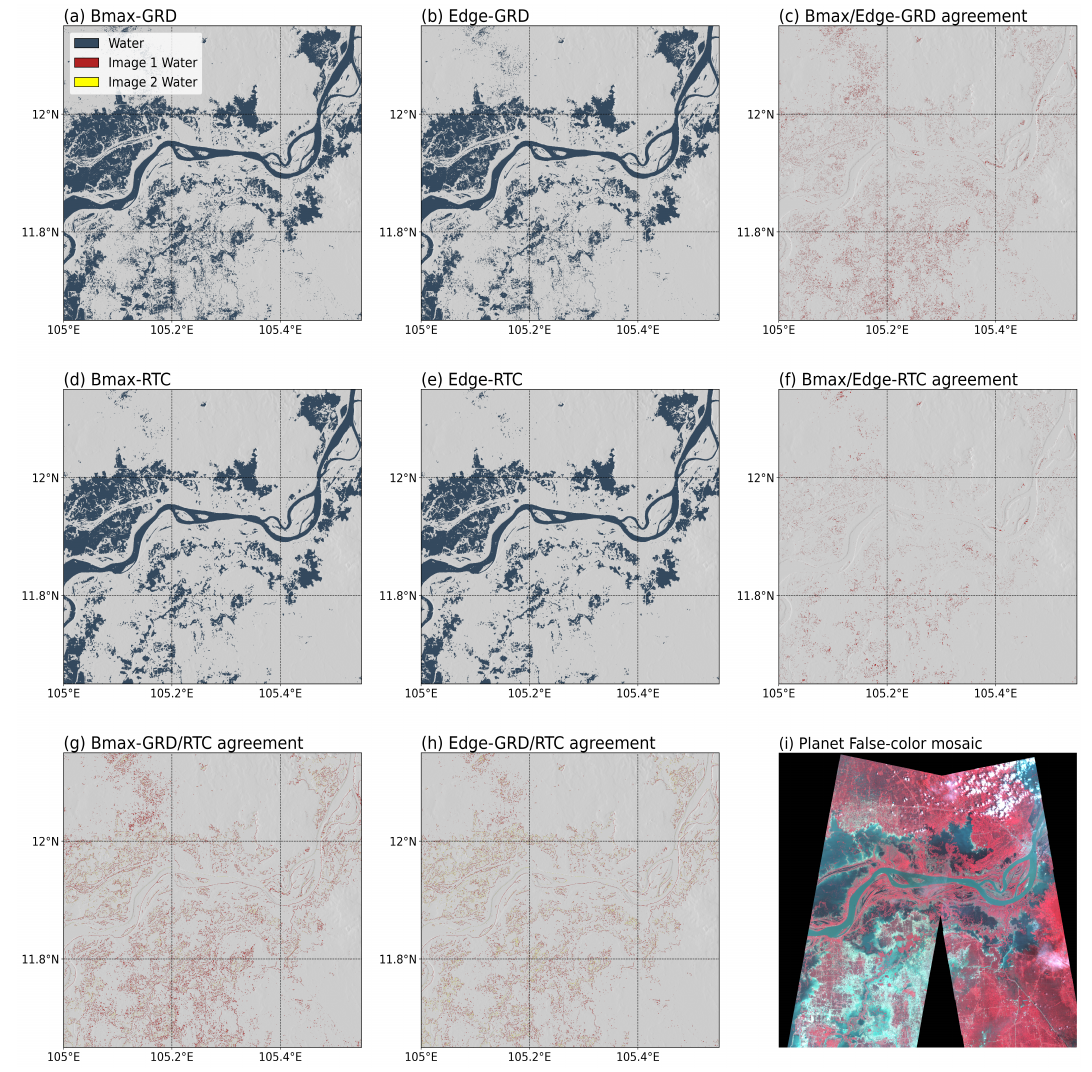
Figure 5. Surface water maps generated over the Tonlé Sap River and Lake in Cambodia for 2019-10-05 using the Bmax Ostu algorithm with the GRD dataset ( a ) and RTC datasets ( d ), as well as the Edge Otsu algorithm with GRD ( b ) and RTC ( e ) data. Difference maps between the methods using either the GRD (c) or RTC ( f ) datasets are provided. The difference maps between datasets using either the Bmax Ostu ( g ) and Edge Otsu ( h ) algorithms is also provided. Image differences are denoted in either red for areas only water from Image 1 is present and yellow for for areas only water from Image 2 is present. Image 1 for the difference maps is the first image used to find the difference starting from either top row or left column whereas Image 2 is the second image across rows or down columns. The corresponding Planet imagery for the region and date ( i